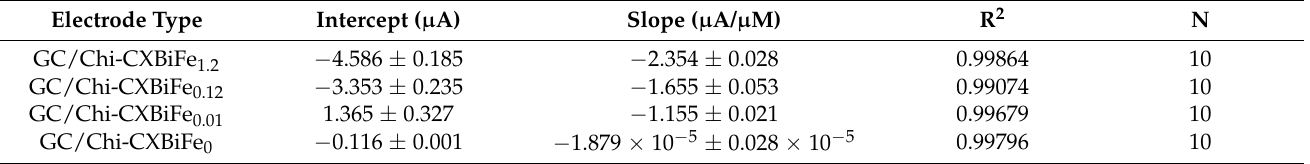
Table 4. Linear regression parameters for amperometric detection of H 2 O 2 at GC/Chi–CXBiFe x .